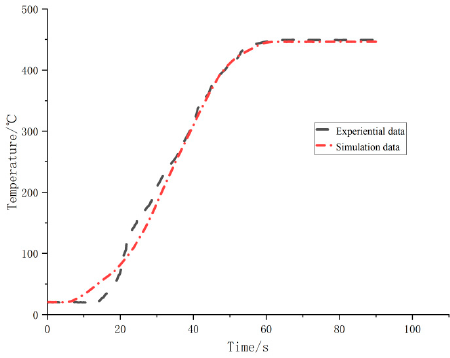
Figure 5. Temperature contrast diagram.